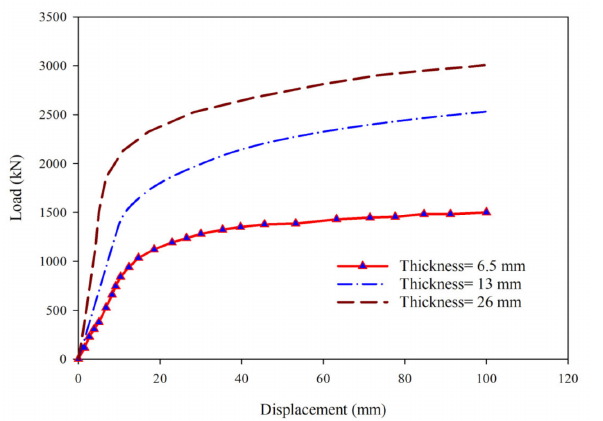
Figure 13. Load–displacement curves of numerical models with different thicknesses of